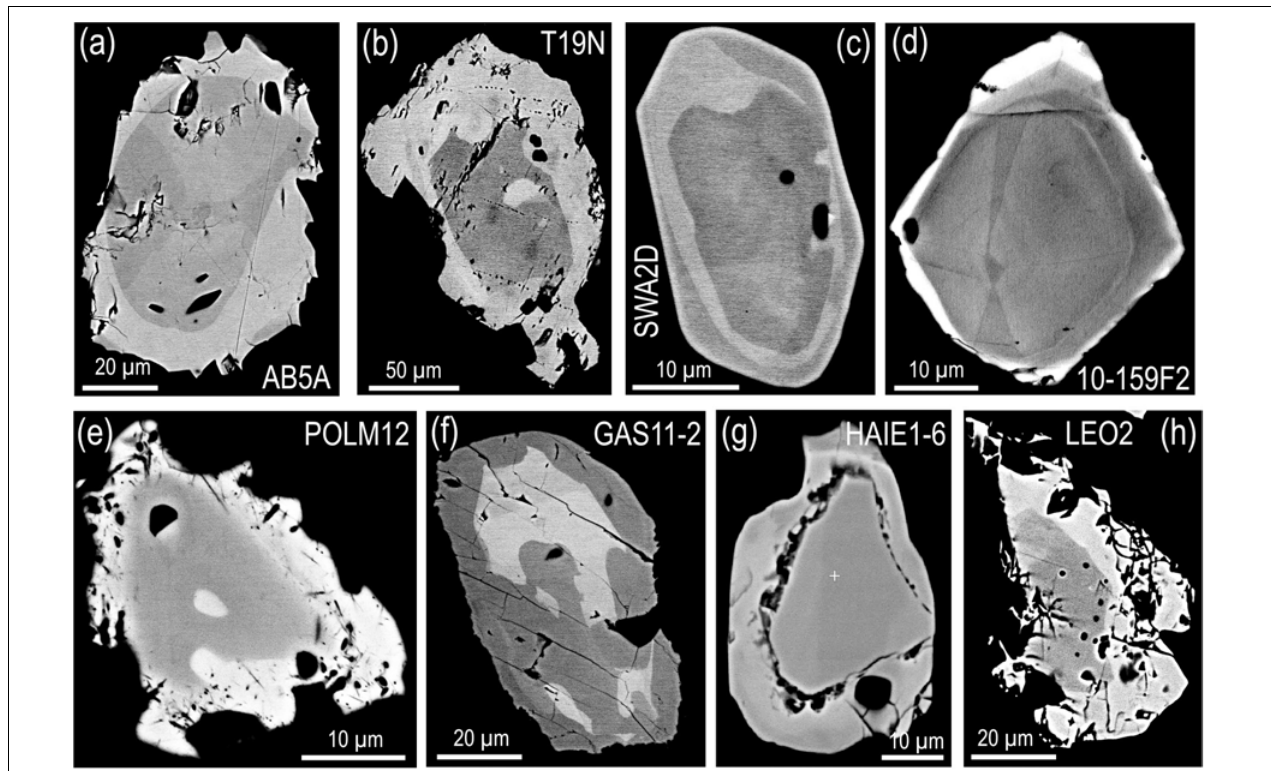
FIGURE 5 | Monazite with striking concentric zonations. (a,b) Th-rich broad rim domains in monazites from high-grade gneisses. (c) Double concentric zonation of a monazite in high-grade mica gneiss from the Saxonian Granulite Massif. (d) Th-rich small rim zone in a monazite from a granite clast in the suevite impact breccia of Nördlinger Ries. (e) Monazite with an inclusion- and Th-rich rim zone in the Eibenstock granite, Western Erzgebirge. (f) Monazite with Th-poor dark broad rim zone. (g) Conchoidal monazite with separated core and mantle in a garnet micaschist from Central Brittany (Schulz, 2013). (h) Zoned monazite with dark Permian-age core and bright Cretaceous-age rim in polymetamorphic garnet micaschist from the Saualpe (Schulz, 2017).